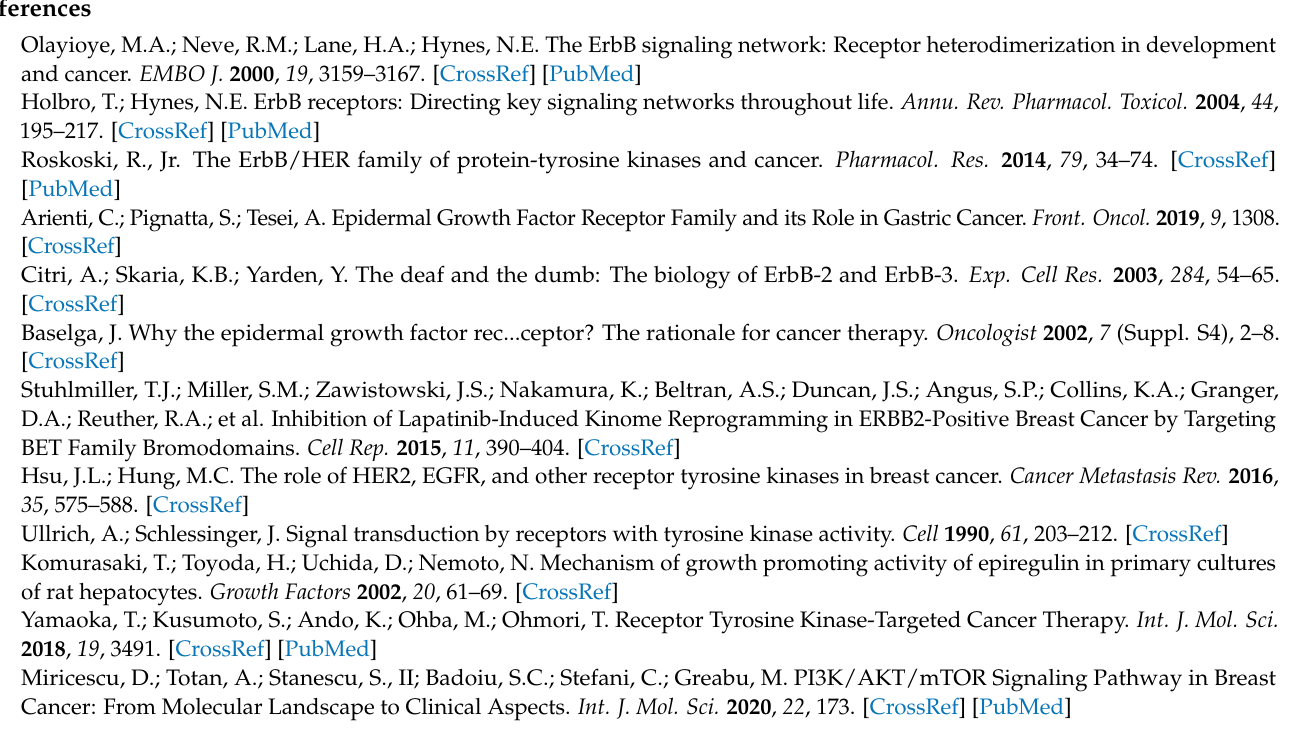
Table S2: Colony formation of BT474 cells in the presence of trastuzumab and 2.5% healthy human serum (samples sd) or HER2-positive BC patients